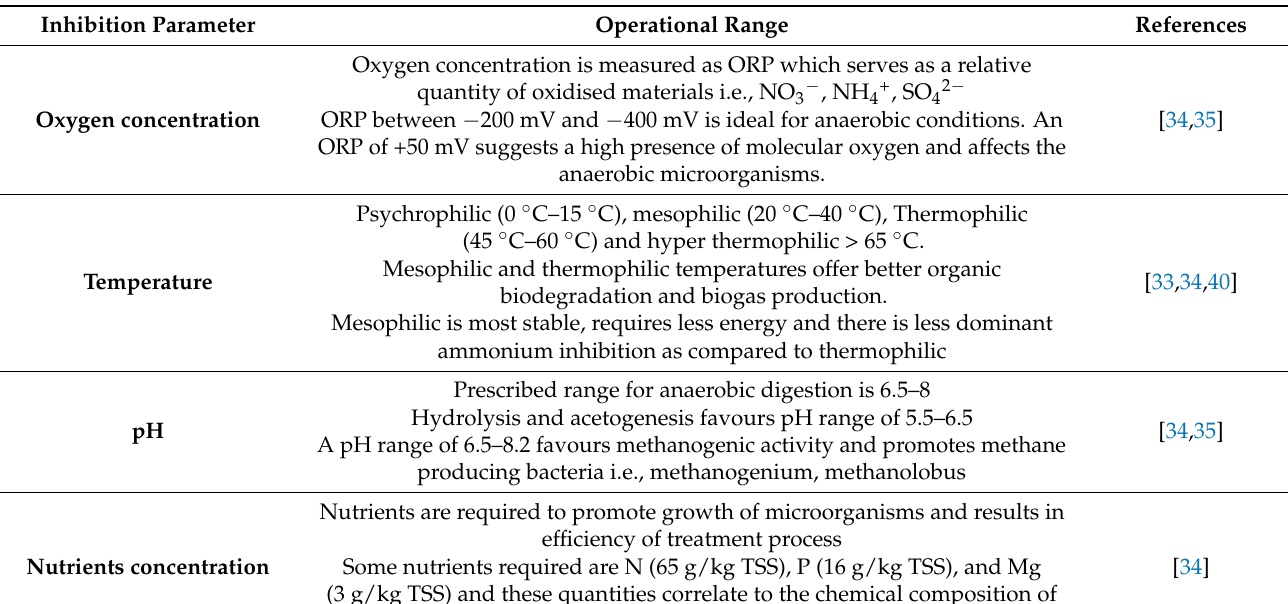
Table 2. Inhibition factors in anaerobic